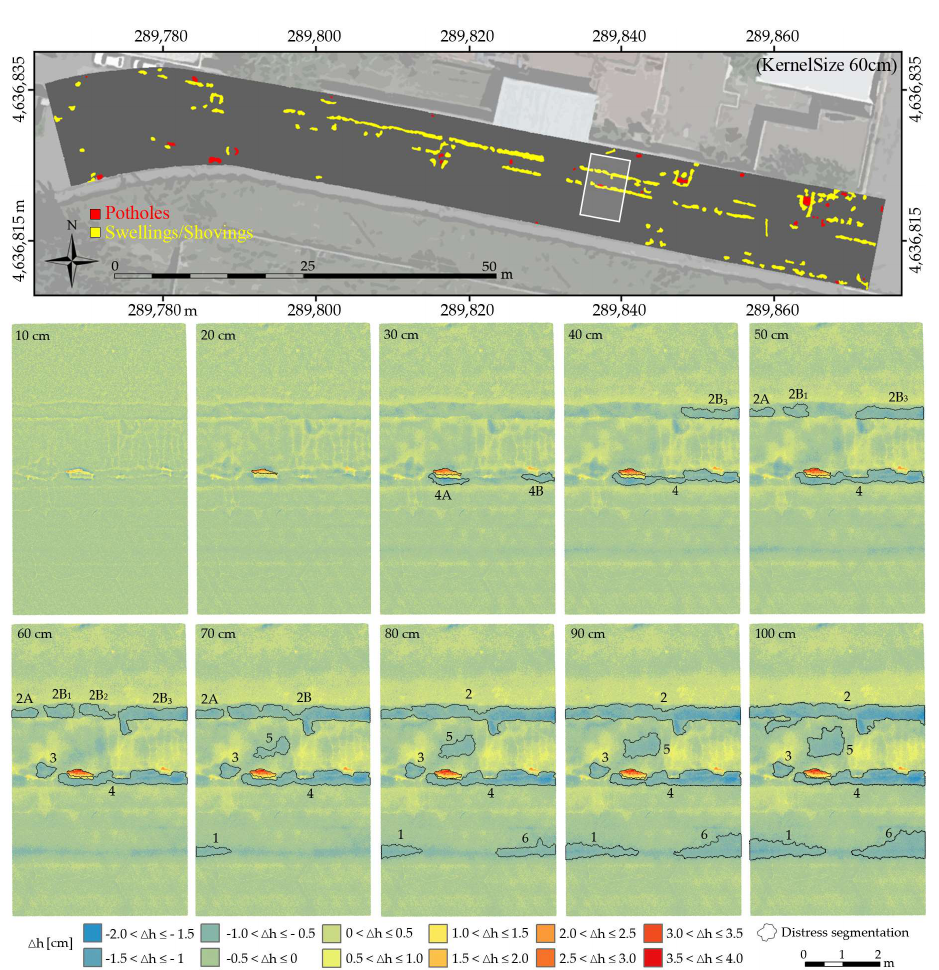
Figure 15. Distresses gradually identified, as the kernel size changes. Positive values of ∆ h correspond to potholes and negative values to swells/shoves.